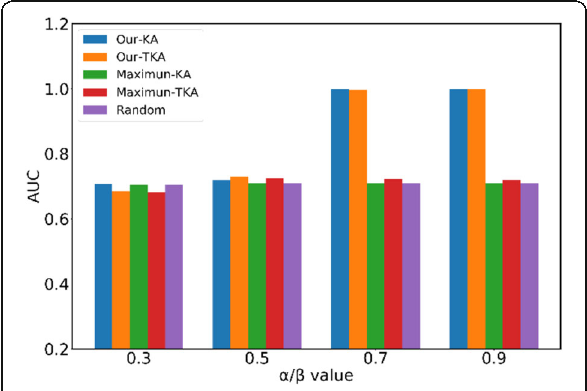
Fig. 4 The different parameters are employed in the weighted similarity function WCN, and λ = 0.3 to obtain AUC